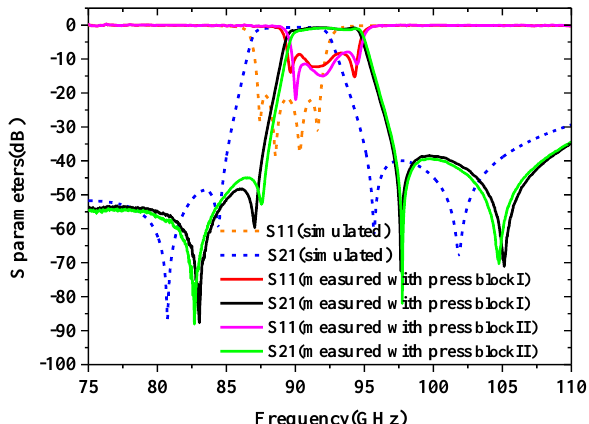
Figure 12. Simulation and measurement results of the designed filter over the whole W -band with two kinds of press block.